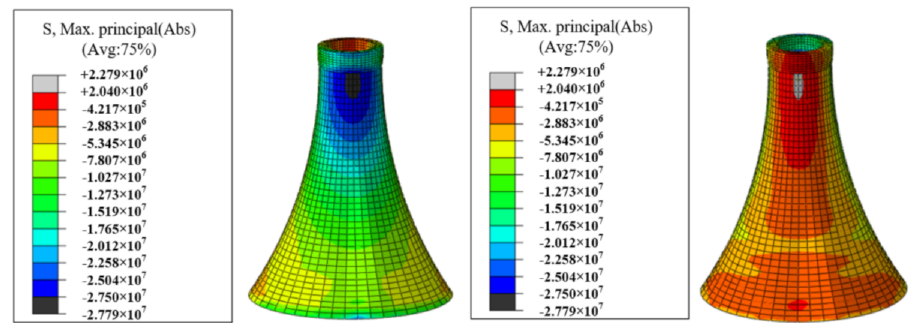
Figure 24. Simultaneous failure area of compression and tension in the transition section of composite bucket foundation.